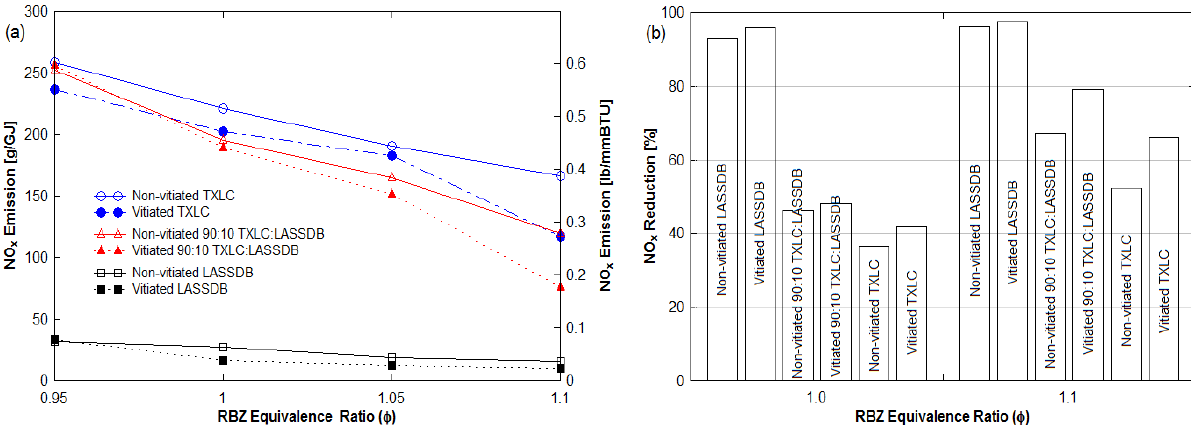
Figure 9. NO x emission with the blends of DB and FB (non-vitiation, 30% heat input and 0° injection).